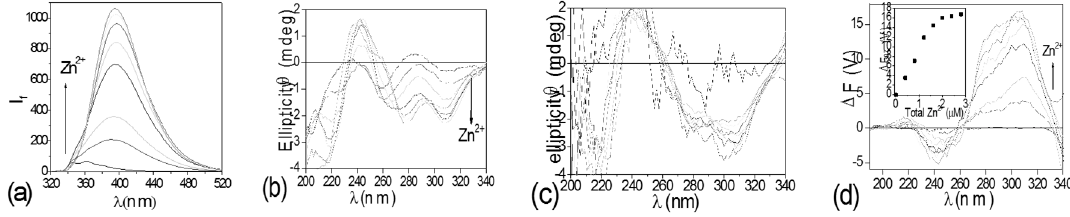
Figure 15. Spectral response of 2 µM ( S , S )- 9 to Zn 2+ in acetonitrile. ( a ) Fluorescence (Ex: 300 nm); ( b ) CD; ( c ) Fluorescence-detected circular dichroism (FDCD); ( d ) Δ F, inset: titration curve of 2 µM ( S , S )- 9 with Zn(ClO 4 ) 2 . Reprinted with permission from Reference [52]. Copyright (2004) American Chemical Society.